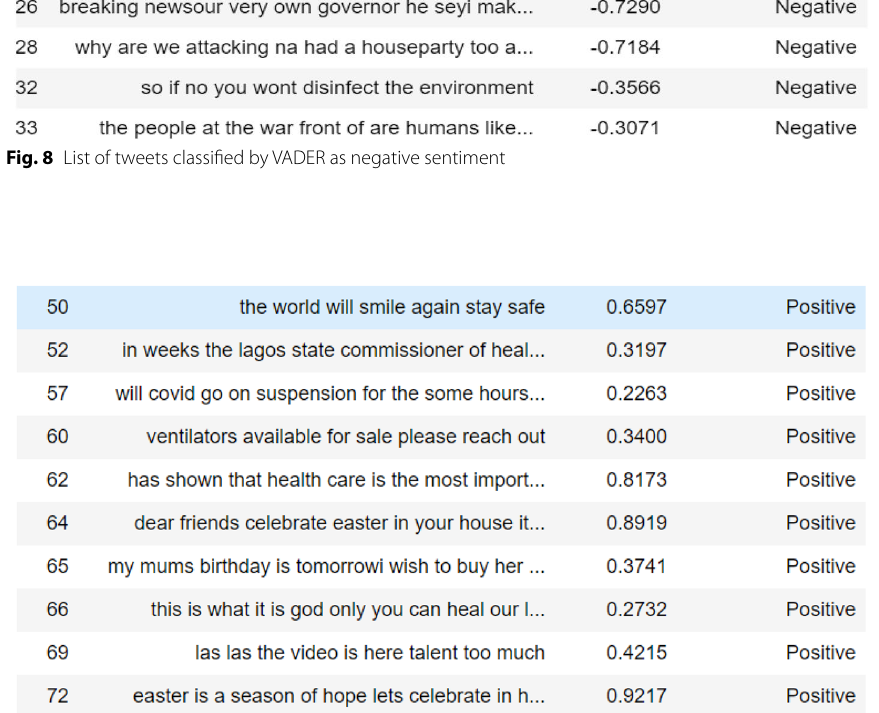
Fig. 9 List of tweets classified by VADER as positive